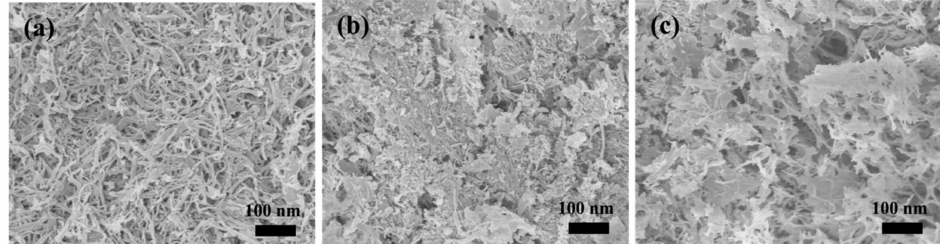
Figure 6. SEM images of MBG scaffold after immersion in SBF for ( a ) 12 h, ( b ) 24 h, and ( c ) 72 h.